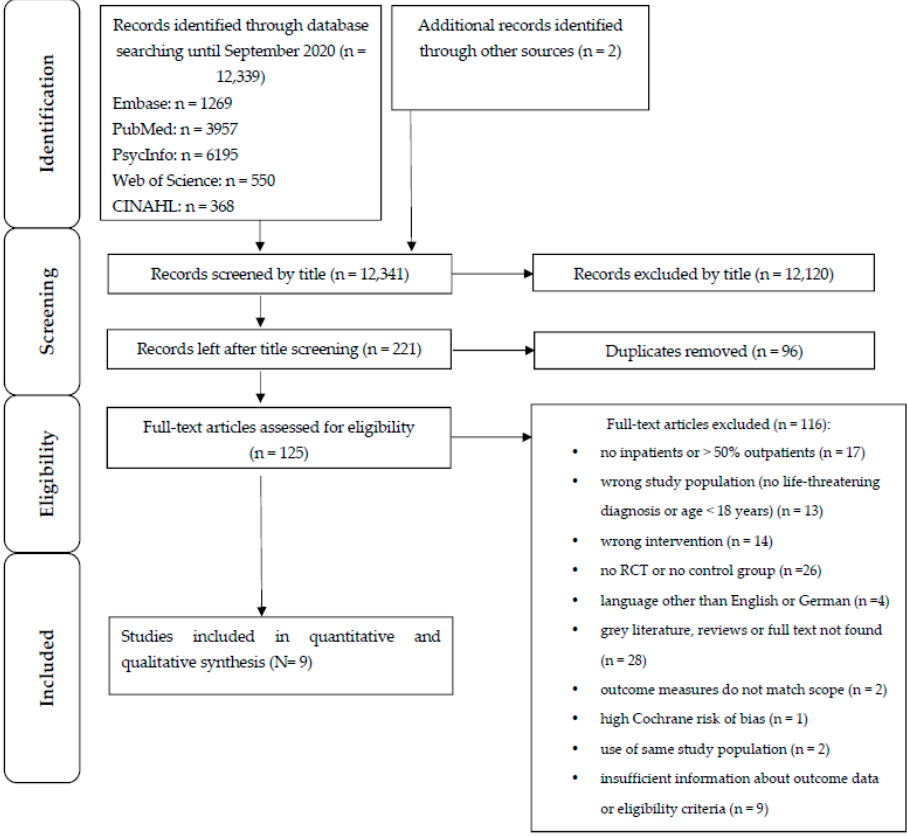
Figure 1. Flow diagram of study selection.